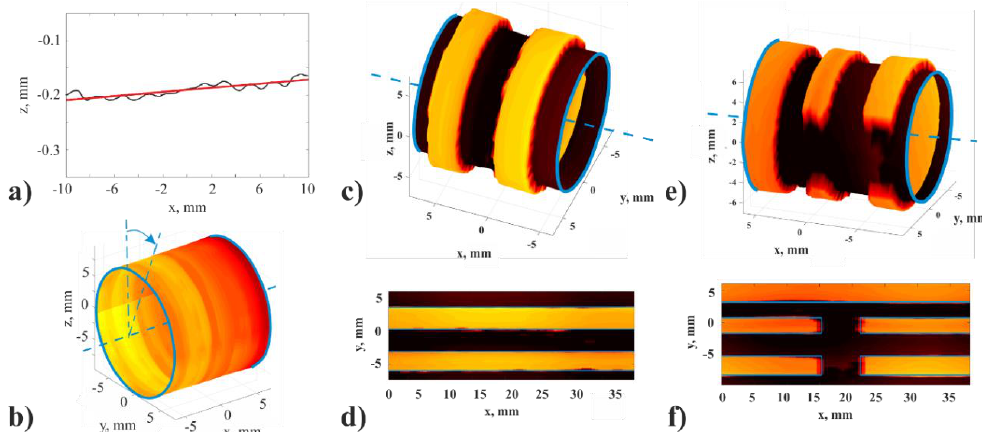
Figure 7. ( a , b ) Line of tomogram maxima and 3D image of a cylindrical sample. ( c , d ) Images of the cylinder with irregular grooves. ( e , f ) Images of the cylinder with irregular grooves and slots. ( c , e ) Reconstructed 3D images of cylinder surface. ( d , f ) 2D projections of the corresponding 3D maps. Bright color denotes more distant parts from the center of the sample, and dark color denotes closer parts to the center. The blue lines are auxiliary, denoting the boundaries of the relief. Adapted with permission from [52], OSA Publishing,